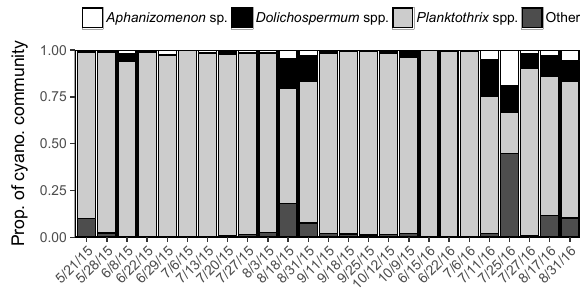
Figure 6. Proportion of cyanobacterial community derived from iTag reads in 2015 and 2016. A single operational taxonomic unit was detected for Aphanizomenon , and multiple operational taxo- nomic units were detected for Dolichospermum and Planktothrix .